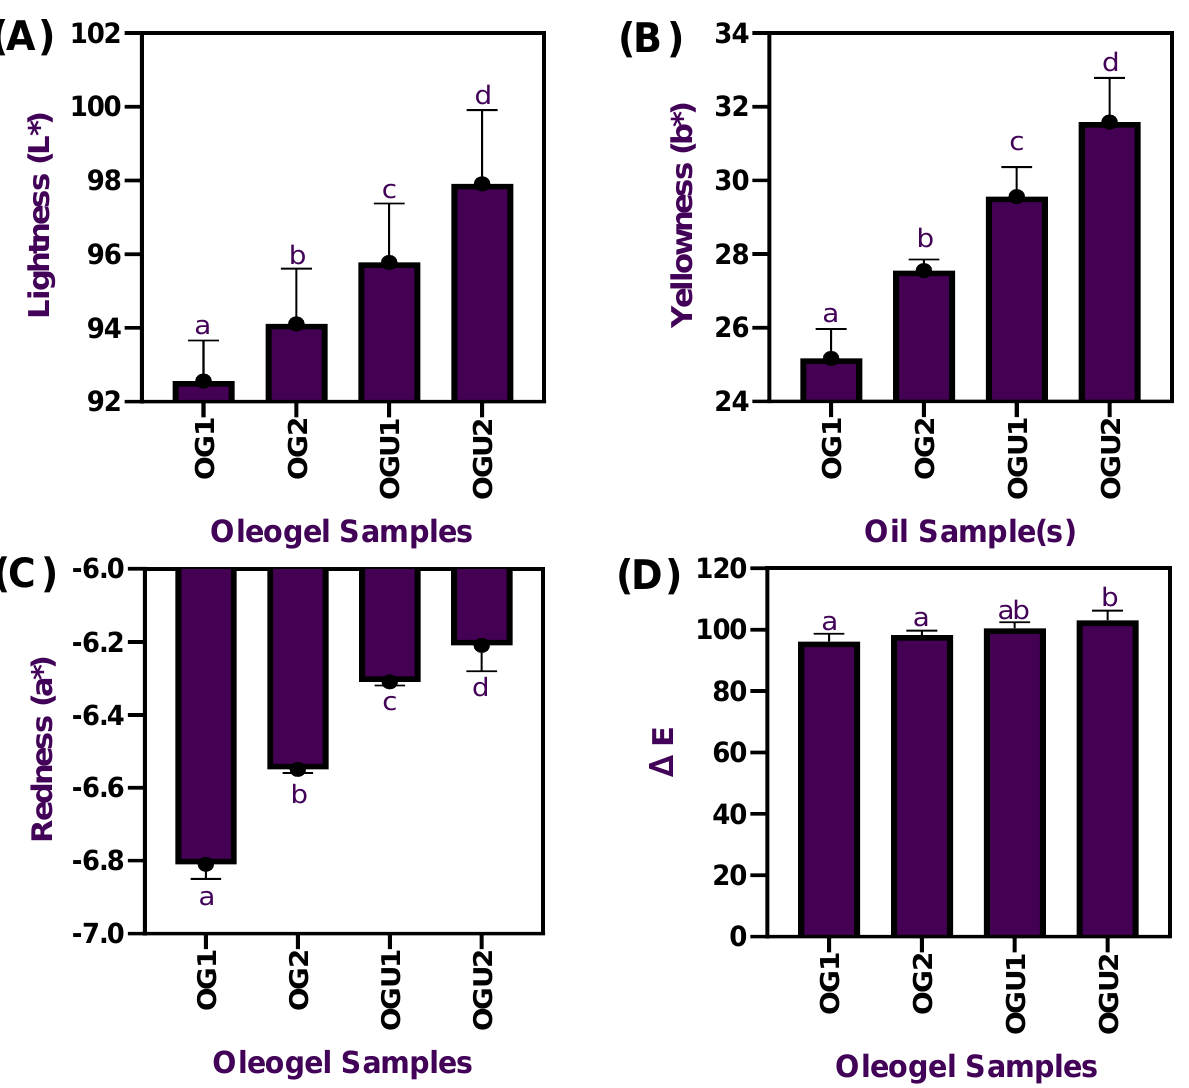
Figure 1. Lightness ( A ), yellowness ( B ), redness ( C ), and total color ( ∆ E) ( D ) of palm oil-based oleogels prepared with different concentrations of carnauba wax and the ultrasonication process.